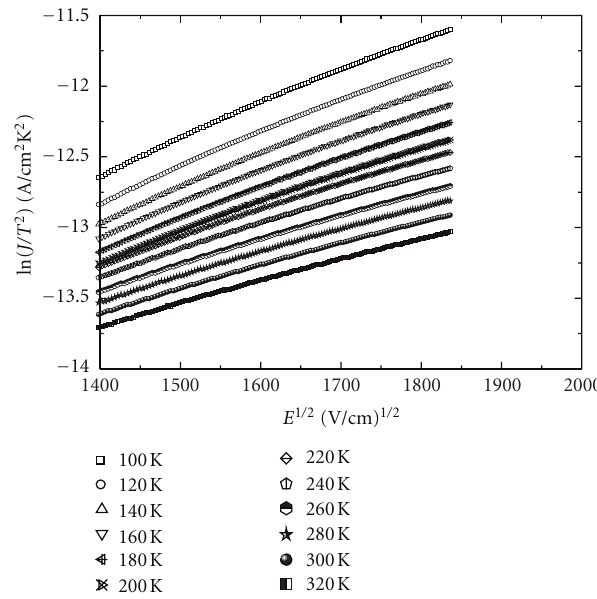
Figure 7: Characteristics of Schottky emission in the region of high field under substrate